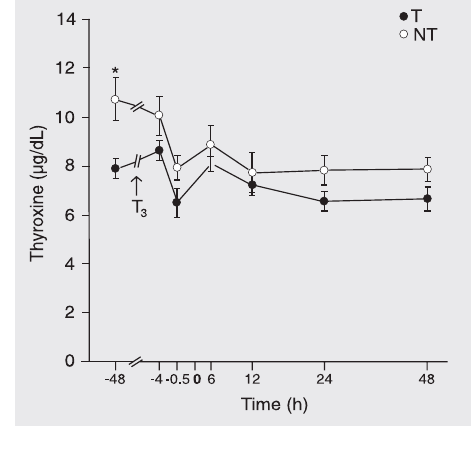
Figure 3. Serum thyrotropin in the groups studied. T = T 3 -treated group, N = 8; NT = placebo-treated group, N = 10; -48 = 2 days before cross-clamp re- moval (baseline); -4 = 1 h before going into surgery and 4 h before cross-clamp removal (24 h after the begin- ning of T 3 or placebo); -0.5 = within 30 min of cardiopul- monary bypass; 0 = cross-clamp removal; 6 = 6 h after aortic cross-clamp removal; 12 = 12 h after aortic cross- clamp removal; 24 = 24 h after aortic cross-clamp removal; 48 = 48 h after aortic cross-clamp removal. *P < 0.05 compared to control (ANOVA for repeated meas- ures; post hoc Student-Newman-Keuls